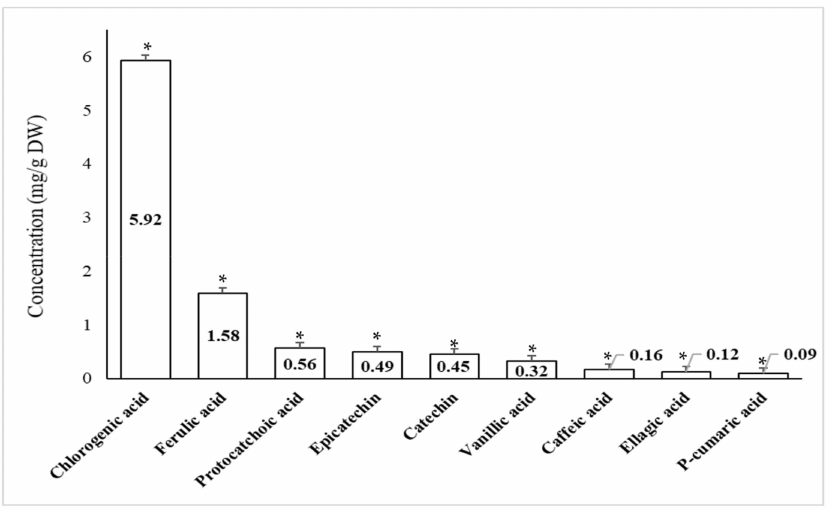
Figure 4. Common phenolic compounds of orange peel powder (Highly significant = * p < 0.01, n =